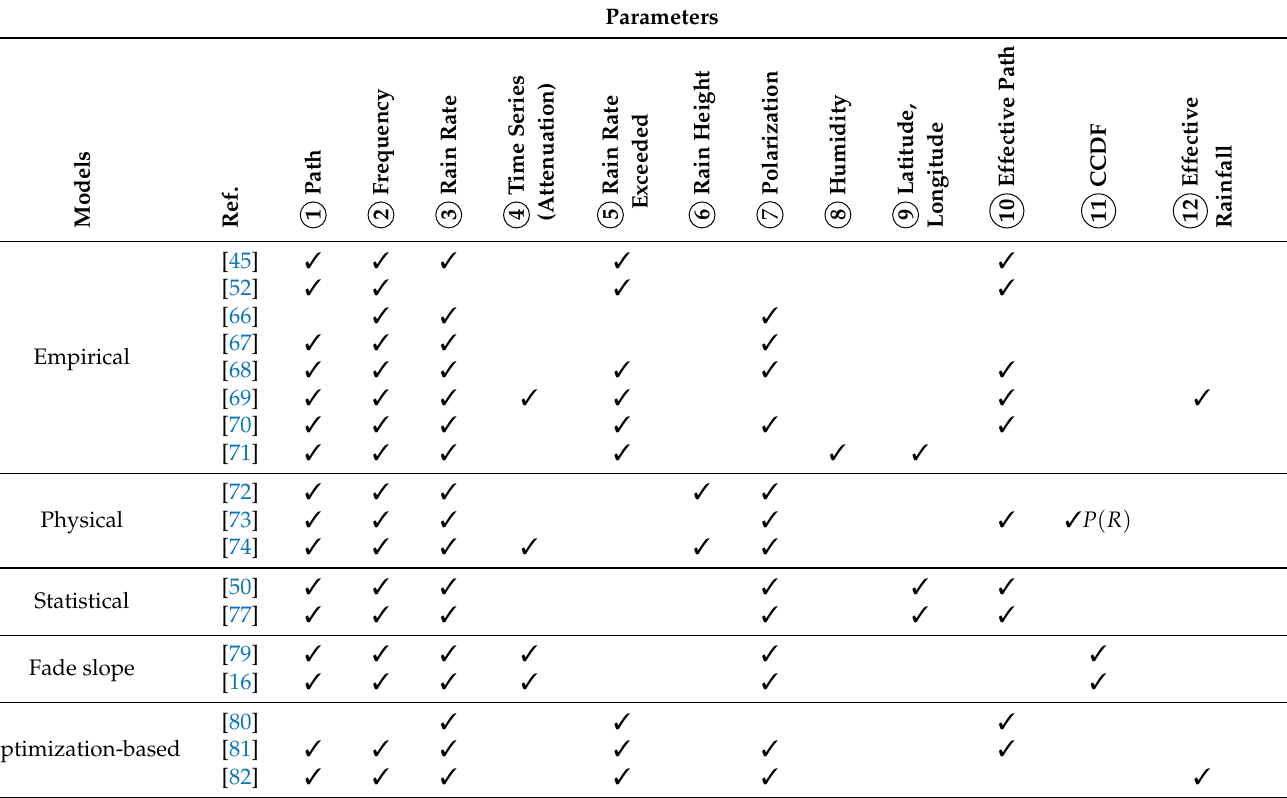
Table 5. Related input parameters/functions of terrestrial rain attenuation models.